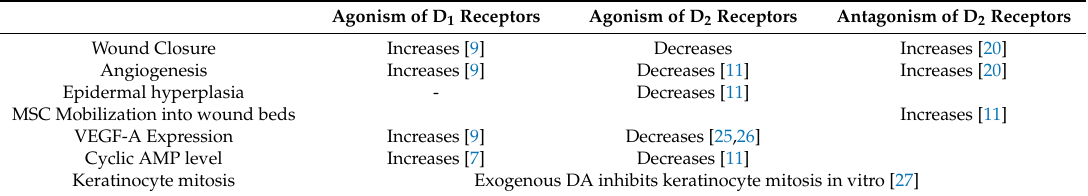
Table 1. Differential Effects on Wound Healing Mediated by DA D 1 versus D 2